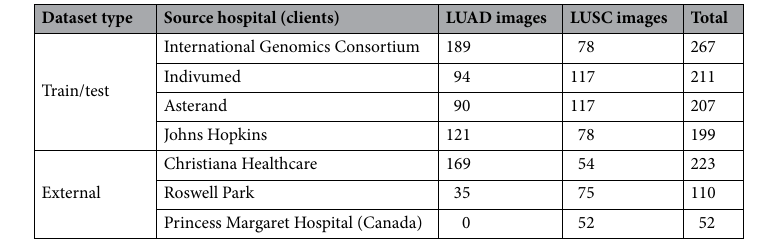
Table 2. Source hospitals for test/train and external dataset and their data distribution.